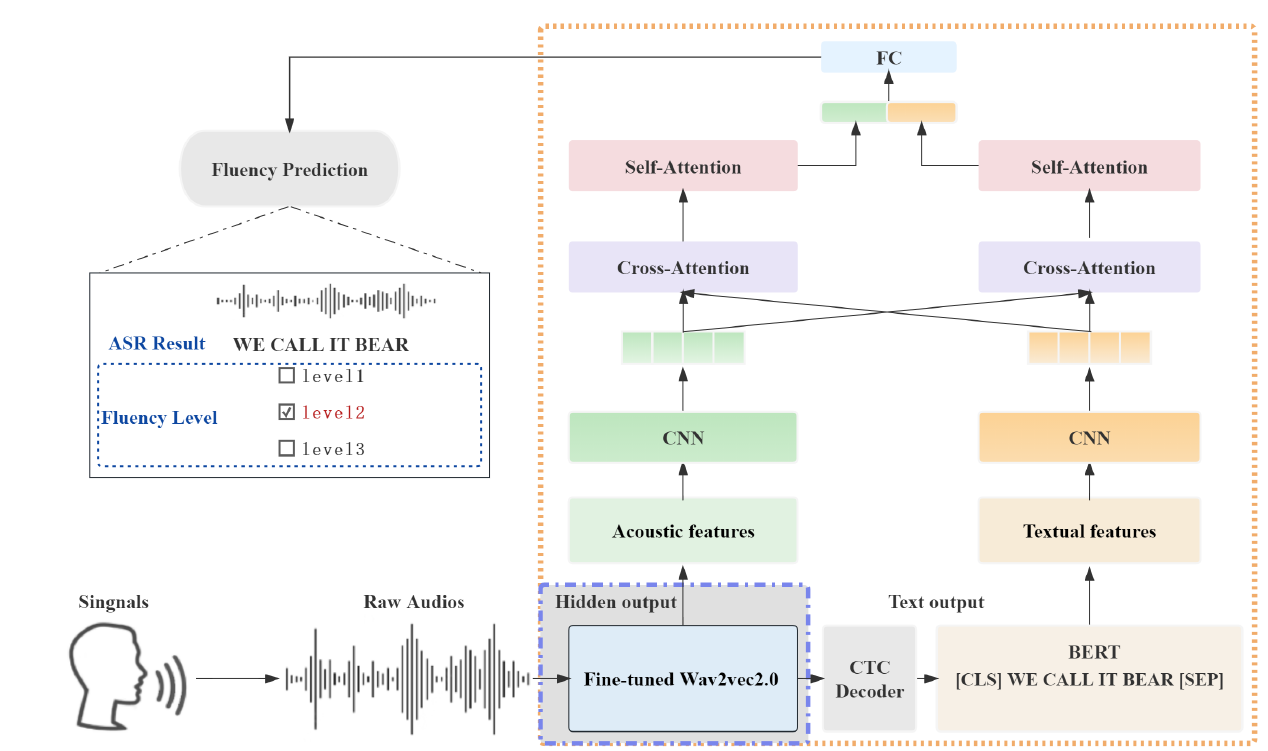
Figure 1. The architecture of the proposed